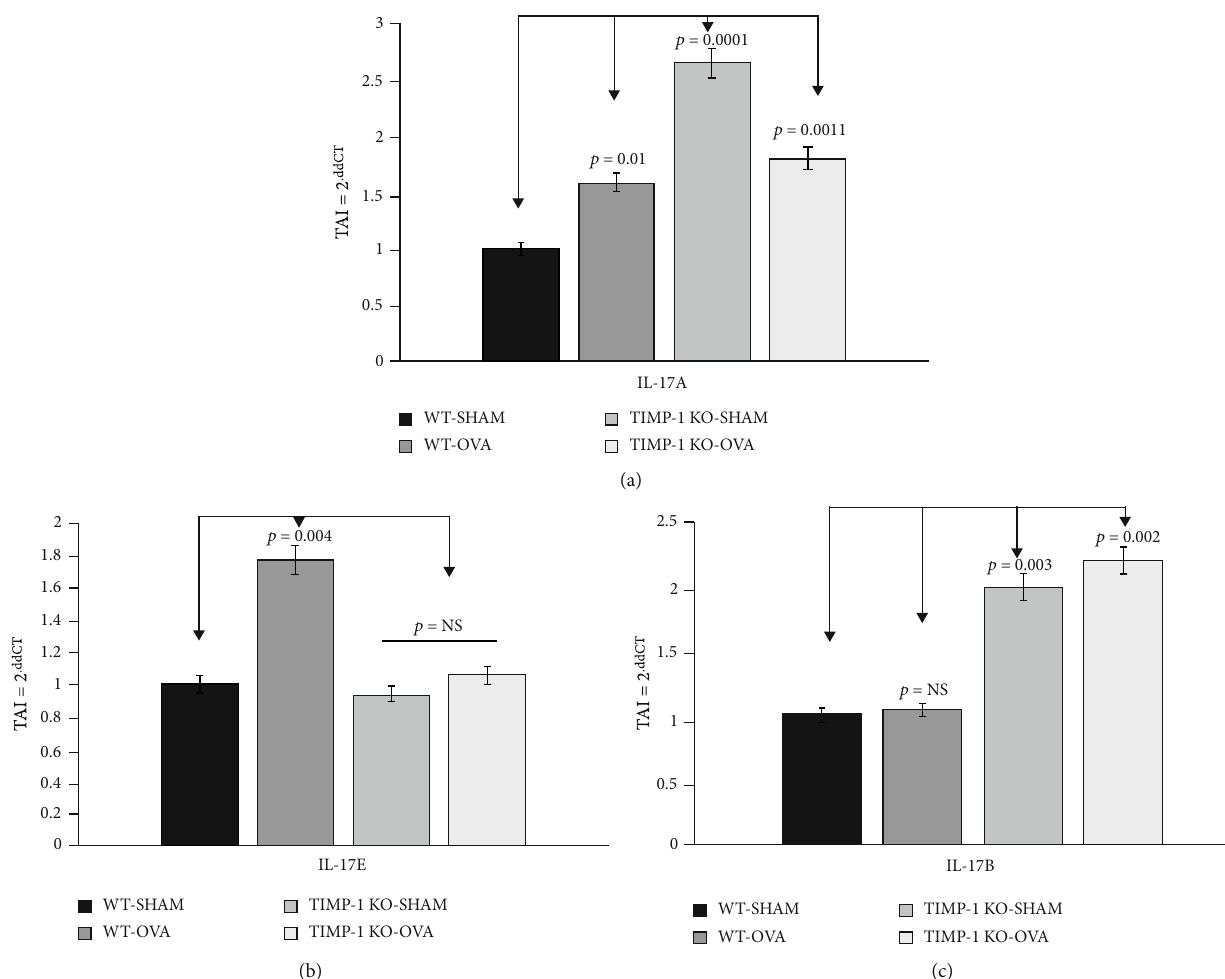
Figure 6: IL-17A, IL-17R β , and IL-17E gene expression in lung tissue obtained from OVA-sensitized TIMPKO, OVA-sensitized TIMPKO, OVA-sensitized WT, and WT-SHAM mice. Comparative real-time qPCR analysis showing relative gene expression of IL-17A, IL-17R β , and IL-17E in lung tissue obtained from OVA-sensitized TIMPKO, OVA-sensitized TIMPKO, OVA-sensitized WT, and WT-SHAM mice. Data normalized to the housekeeping gene β -actin and with WT-SHAM as control. Gene expression was calculated using the comparative CT method. Results expressed as the mean ± SD , n = 3 separate experiments.